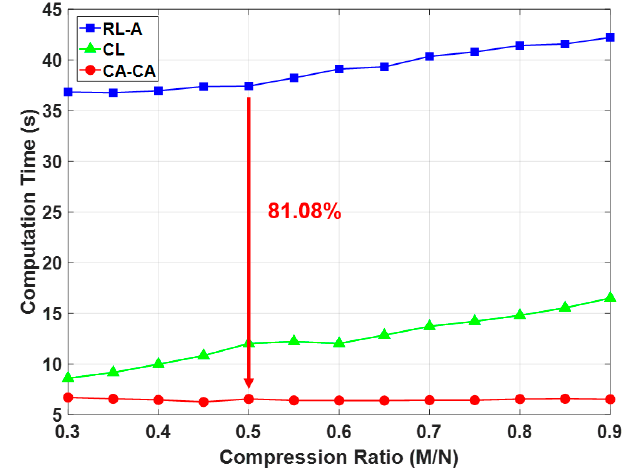
Figure 15. Comparison of computation time under different compression ratio.